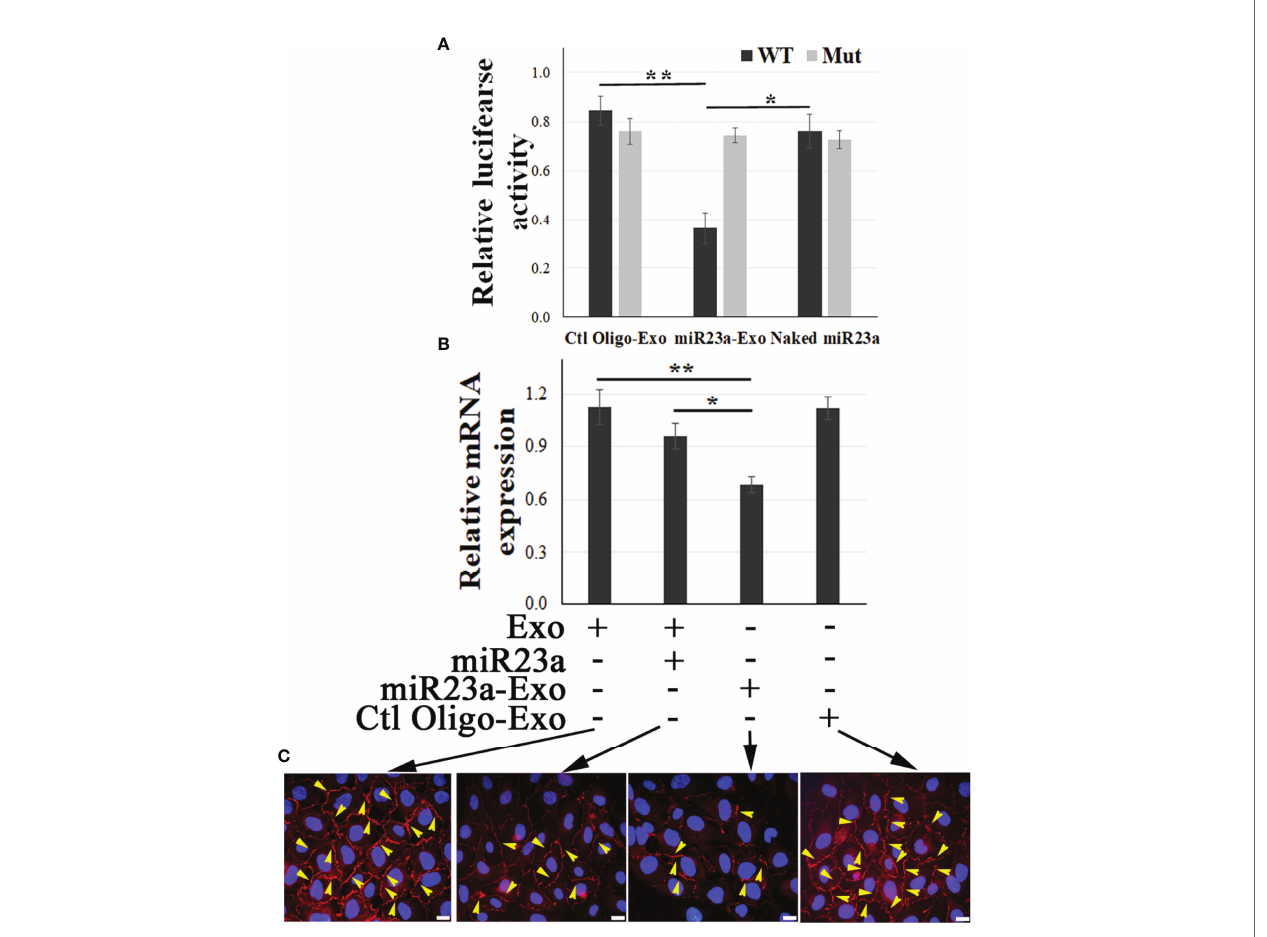
FIGURE 4 | Exosomal miR23a directly targets ZO-1 of recipient BMECs. (A) Luciferase reporter assay in which BMECs were exposed to naked miR23a mimics (2 x 10 -5 pmol/cell), Ctl Oilgo-, or miR23a mimic-enriched ECExos (miR23a-Exo) (1,000 particles/cell) soon after transfection with reporter constructs containing full length 3 ′ UTR wild-type ZO-1 (WT) or mutated miR23a binding sites (Mut). Luciferase activity was quanti fi ed at 24 hrs post exposure. N = 3 independent experiments. * p <0.05; ** p <0.01. (B) Relative expression of ZO-1 mRNA by RT-PCR of recipient BMECs after exposure to naked miR23a mimic (2 x 10 -5 pmol/cell), Ctl Oilgo-, or miR23a mimic-enriched ECExos (miR23a-Exo) (1,000 particles/cell) for 72 hr. (C) ZO-1 immuno fl uorescence in recipient BMECs after exposure to naked miR23a mimics (2 x 10 -5 pmol/cell), Ctl Oilgo-, or miR23a mimic-enriched ECExos (miR23a-Exo) (1,000 particles/cell) for 72